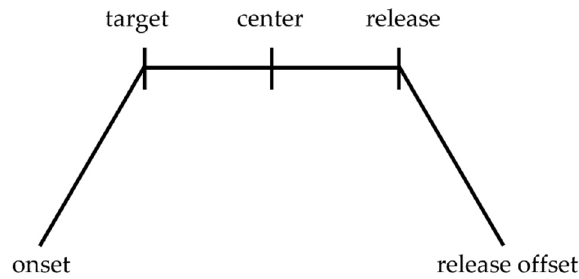
Figure 3. Gestural landmarks, as defined in Gafos (2002).